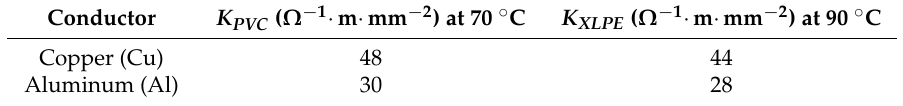
Table 1. Conductivity, K , as a function of temperature of the permanent regime of the insulation.